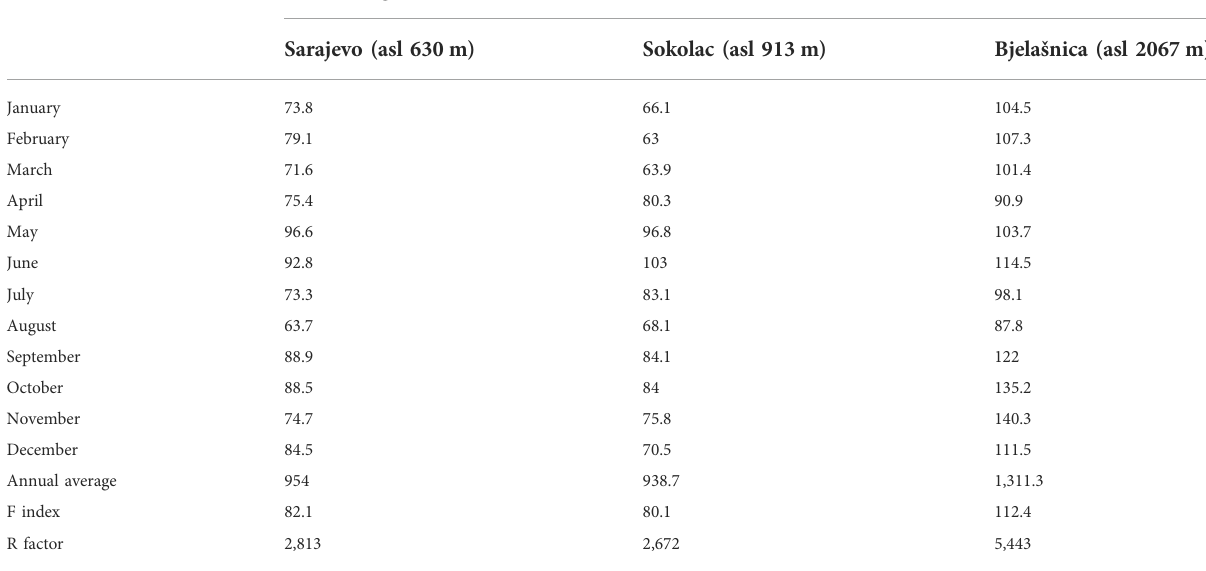
TABLE 1 Average monthly and annual values of precipitation for the period (2000 – 2020) with the resulting R